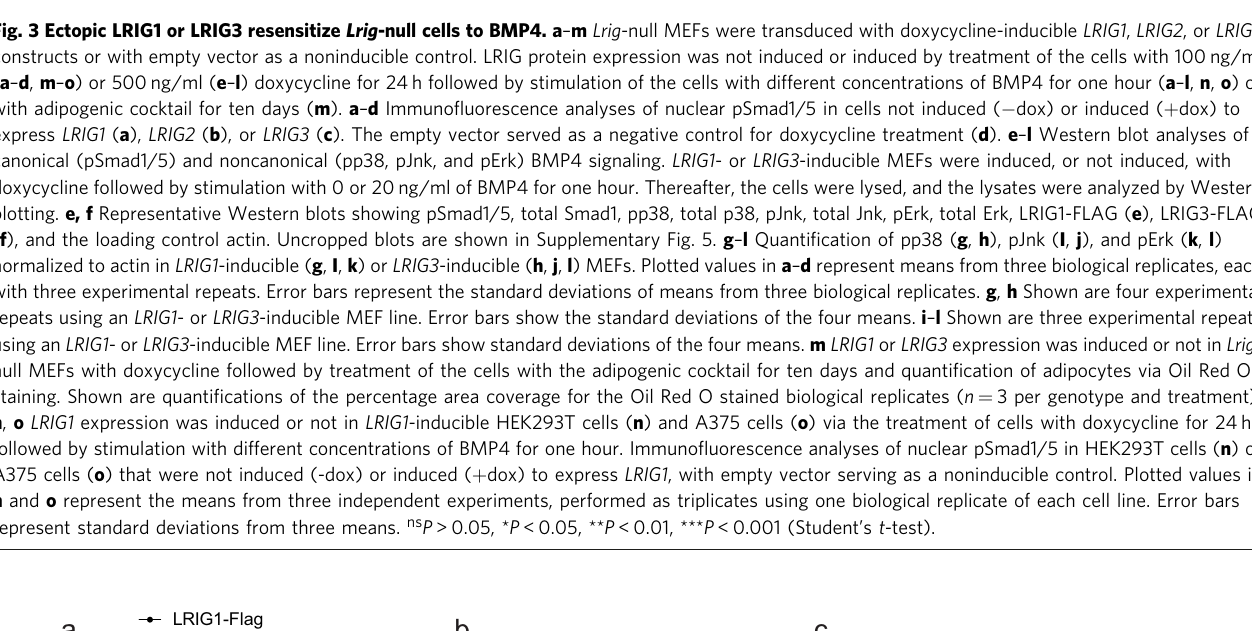
Fig. 3 Ectopic LRIG1 or LRIG3 resensitize Lrig -null cells to BMP4. a – m Lrig -null MEFs were transduced with doxycycline-inducible LRIG1 , LRIG2 , or LRIG3 constructs or with empty vector as a noninducible control. LRIG protein expression was not induced or induced by treatment of the cells with 100 ng/ml ( a – d , m – o ) or 500 ng/ml ( e – l ) doxycycline for 24 h followed by stimulation of the cells with different concentrations of BMP4 for one hour ( a – l , n , o ) or with adipogenic cocktail for ten days ( m ). a – d Immuno fl uorescence analyses of nuclear pSmad1/5 in cells not induced ( − dox) or induced ( + dox) to